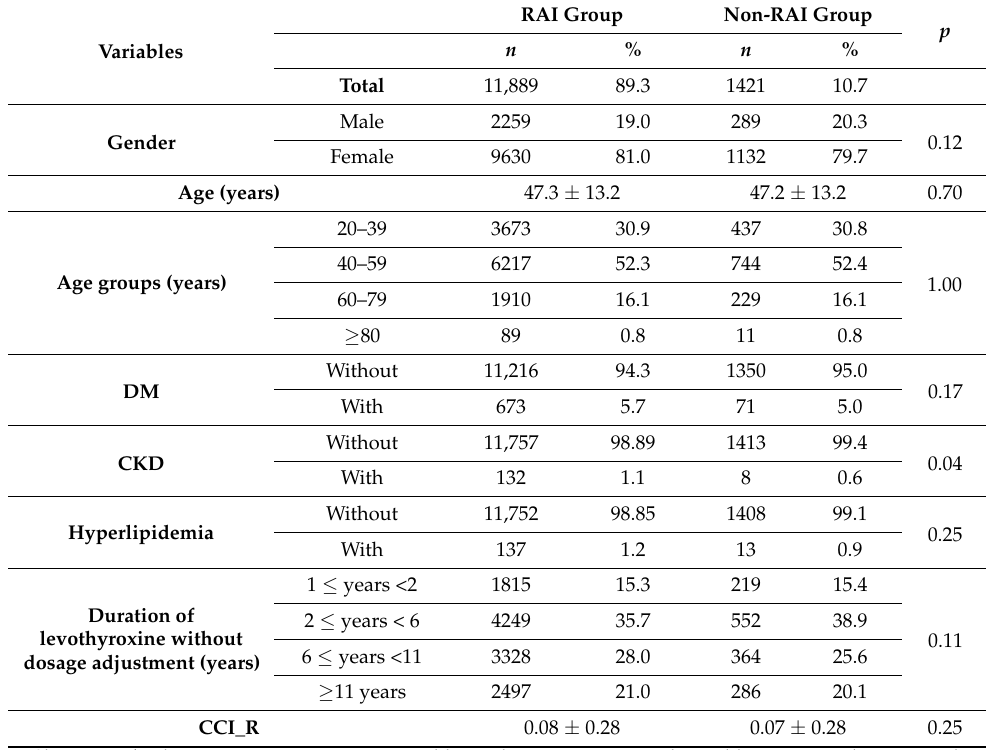
Table 1. Characteristics of the control and study groups at baseline.